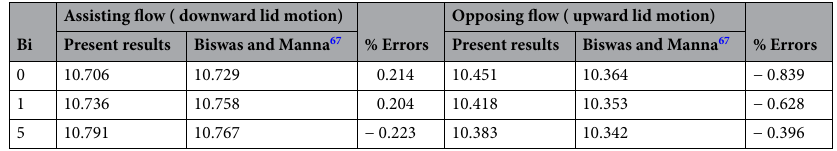
Table 4. Comparison of the average Nusselt number for the different values of Biot number at Re = 200, Gr = 10 5 , Ma = 1000 .